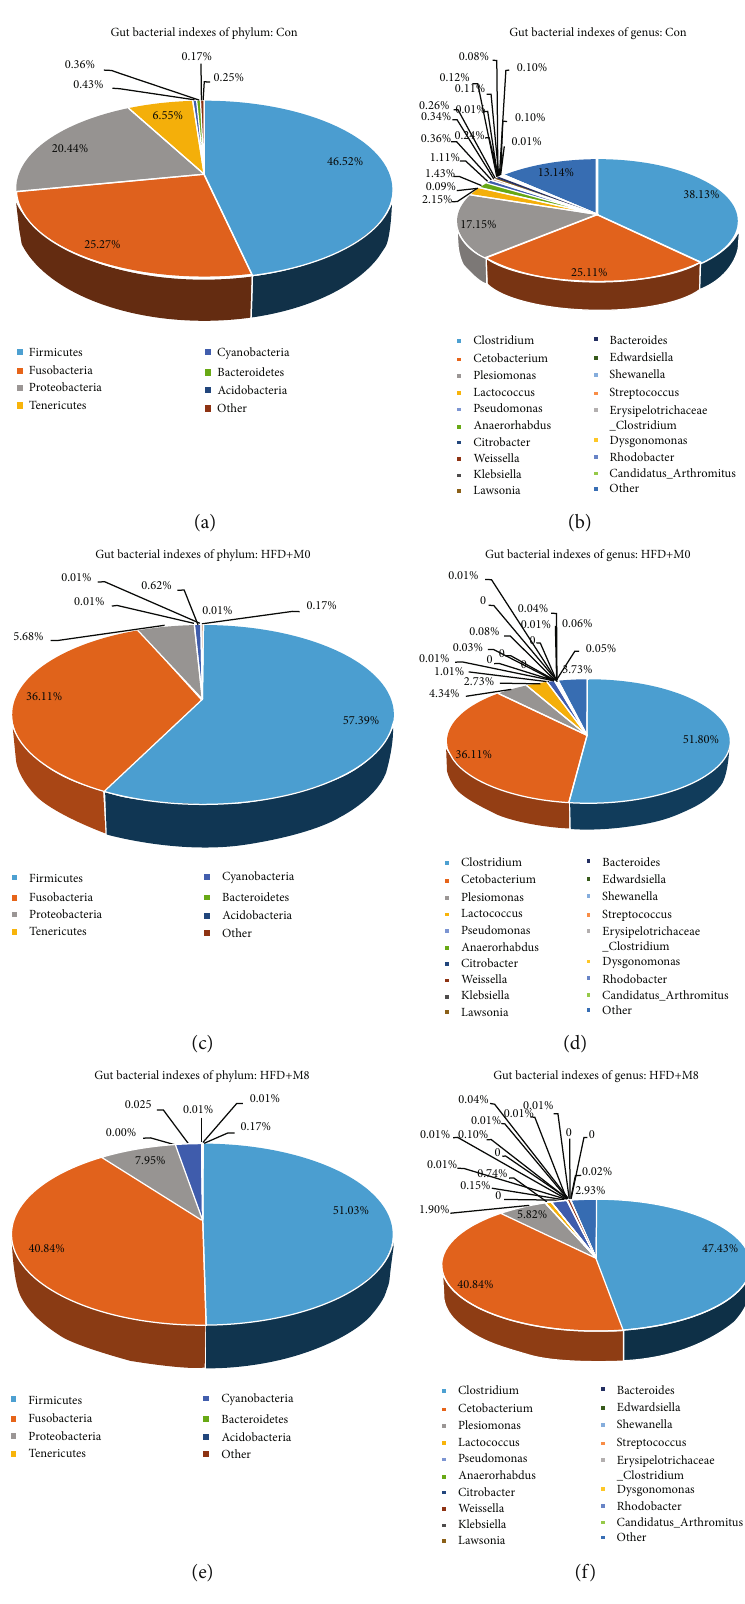
Figure 5: E ff ects of high-fat diet-supplemented methionine on gut bacterial indices of the phylum (a, c, e) and the genus (b, d, f) ( n = 3